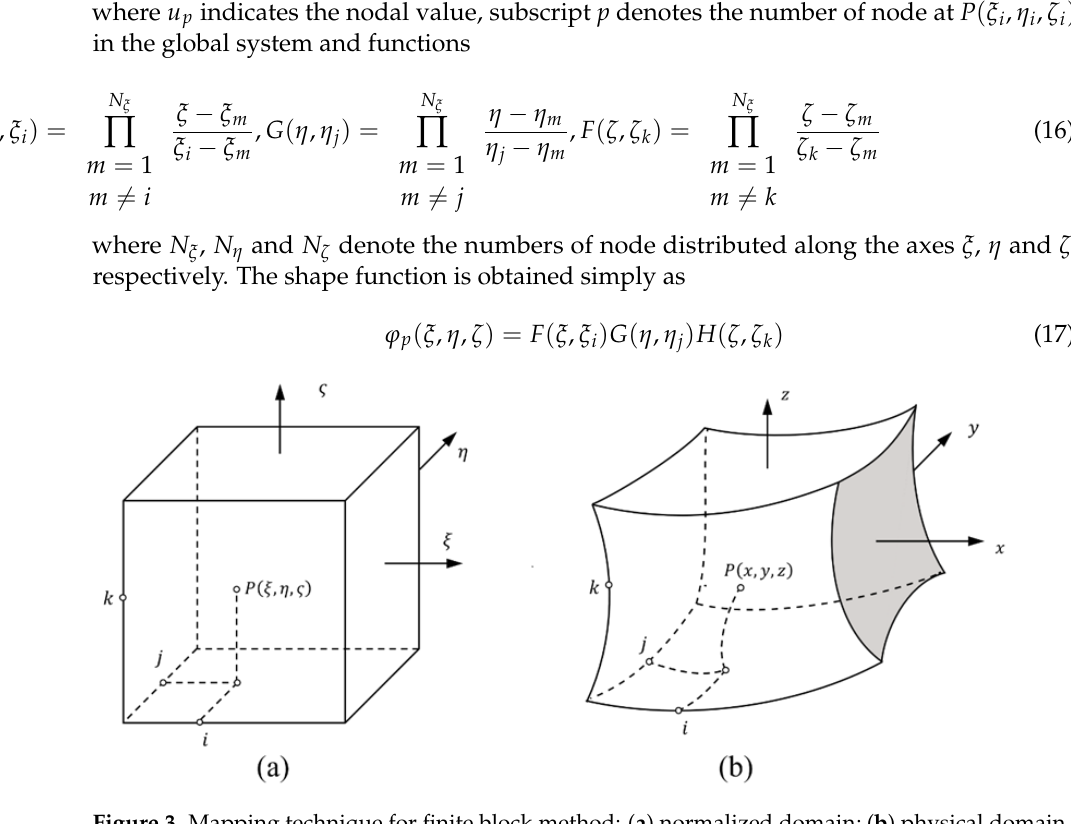
Figure 3. Mapping technique for finite block method: ( a ) normalized domain; ( b ) physical domain.